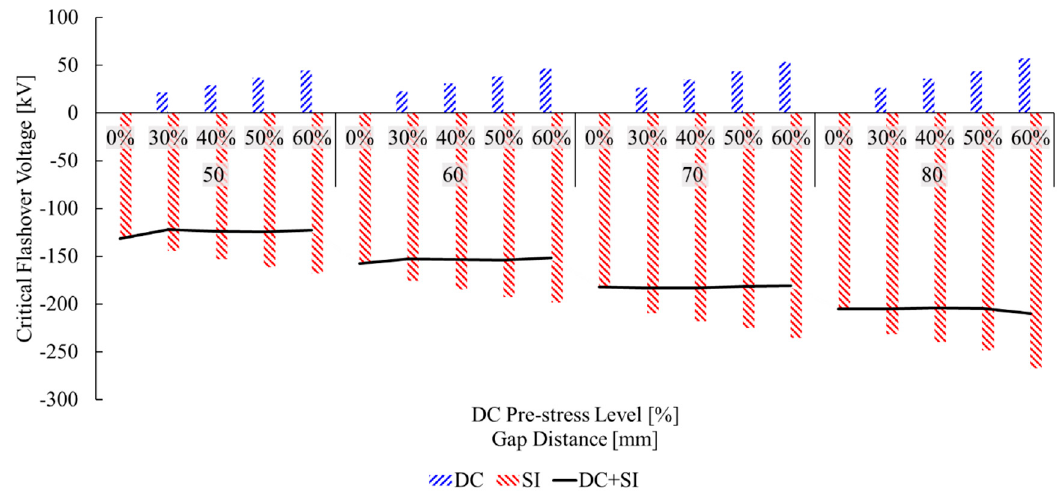
Figure 11. The experiment results of positive DC superimposed negative switching impulse for R10.